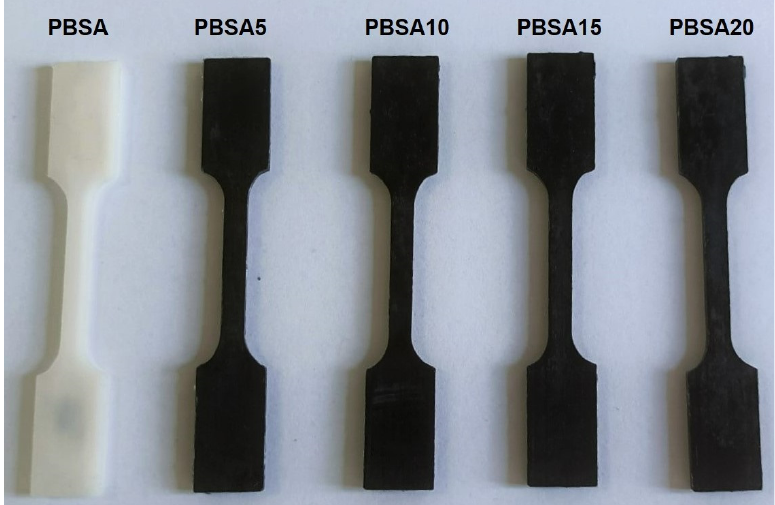
Table 3. Mechanical properties of PBSA and PBSA/BC specimens. Mean values ± standard deviation of 5 replicates. (*) Yield strength and elongation at yield equal stress at break and elongation at break, respectively.